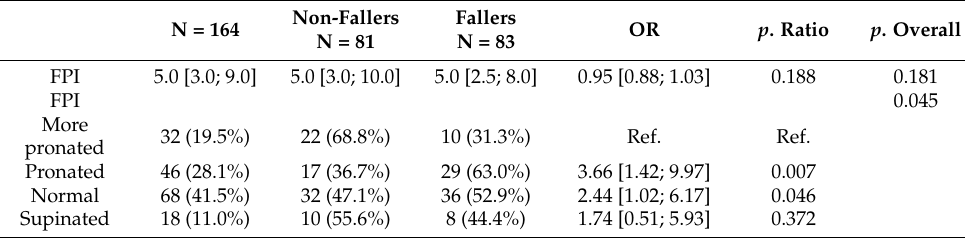
Table 2. Relationship of the general FPI and the foot anatomical structural pathologies.